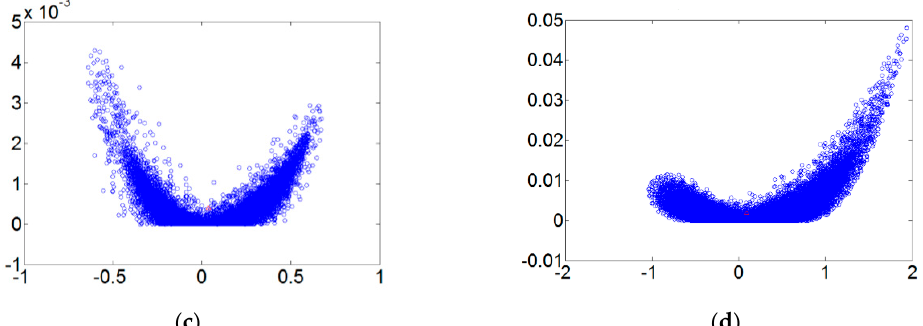
Figure 7. The order 0.7 fault dynamic error trace diagrams for all fault diameters. ( a ) Normal state; ( b ) fault diameter = 0.007; ( c ) fault diameter = 0.014; ( d ) fault diameter = 0.021.